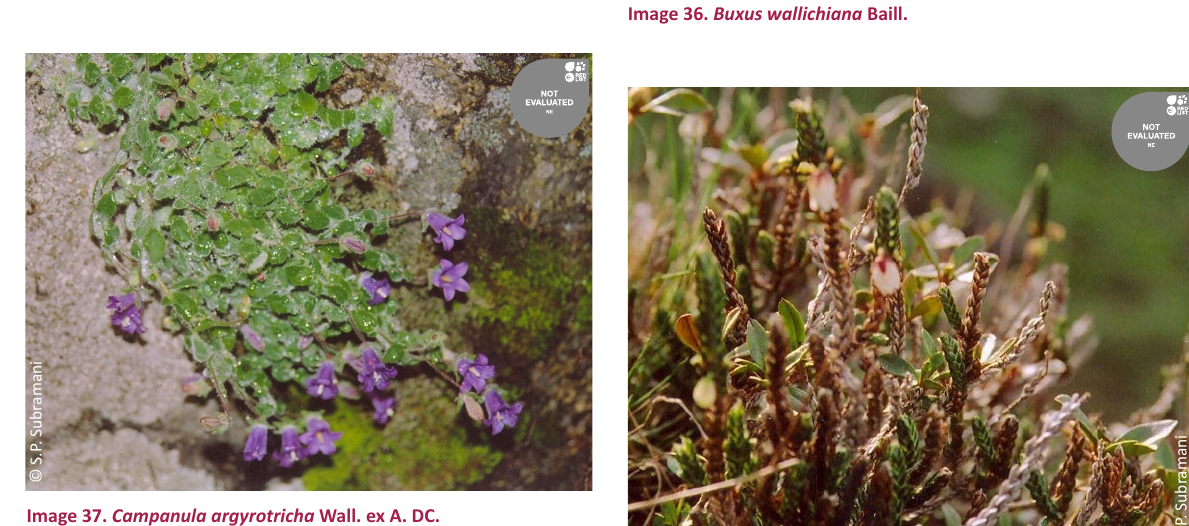
Image 37. Campanula argyrotricha Wall. ex A. DC.